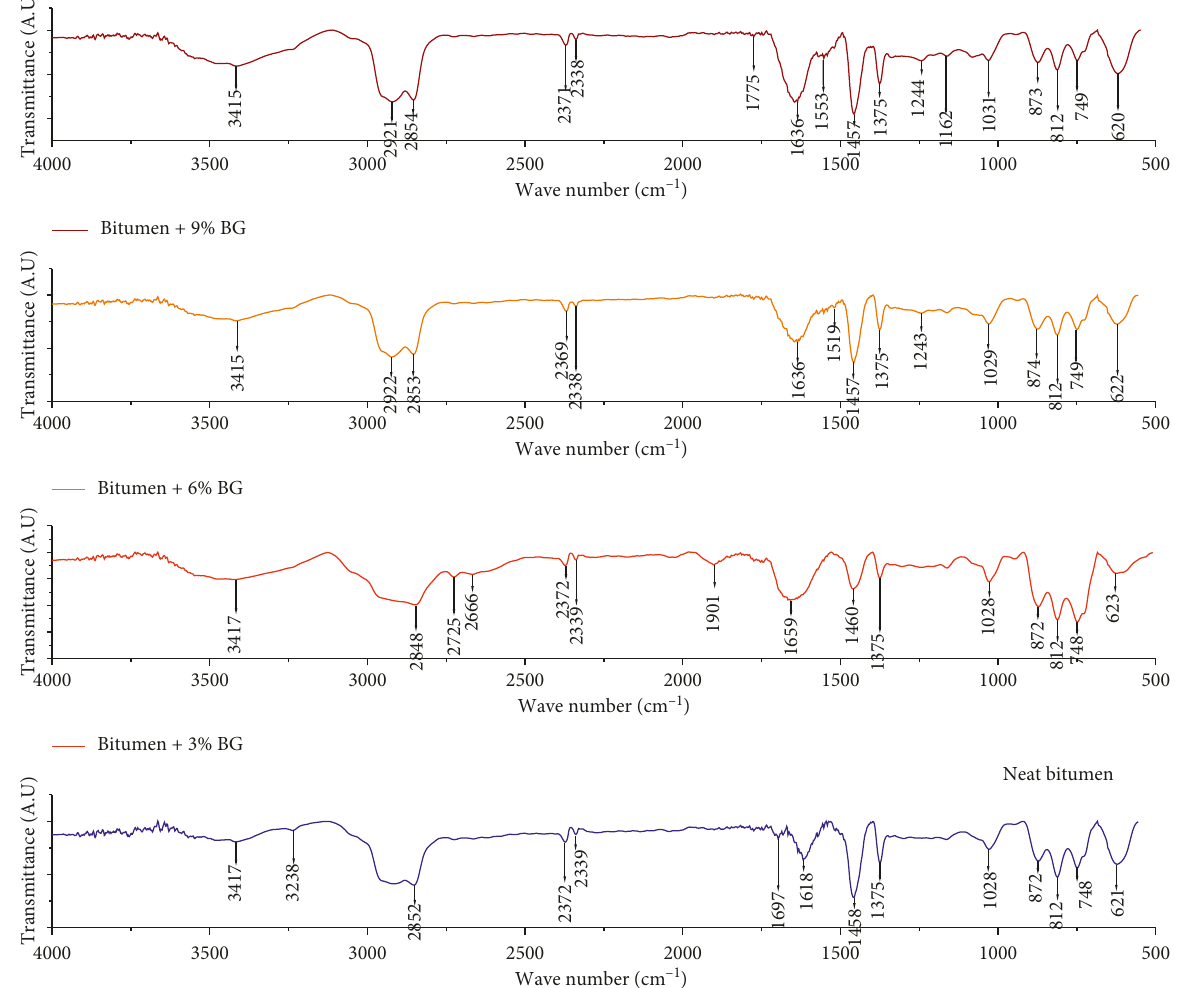
Figure 3: FTIR results of neat and modified